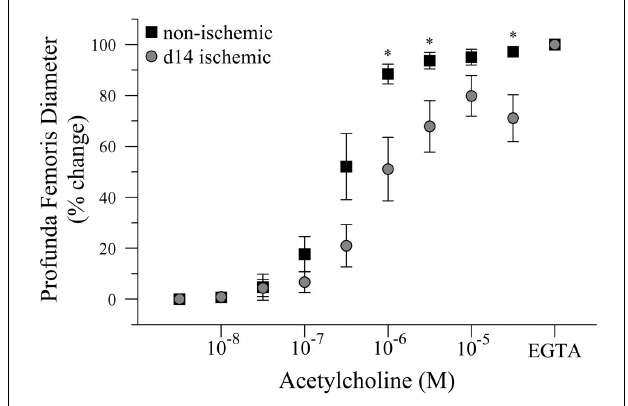
FIGURE 4 | Dose response curve to acetylcholine in ischemic and non-ischemic distal profunda femoris arteries, ex vivo . Vessels were pressurized to 80mmHg (baseline) and developed myogenic tone before exposure to the initial dose of Ach (10 − 8 M); increasing doses were applied at 3 × 10 − x M increments. Data points are on a relative scale, with myogenic tone represented as 0% and maximal passive vasodilation represented as 100% (Ca + 2 -free PSS + EGTA). ∗ p ≤ 0.05 versus day-14